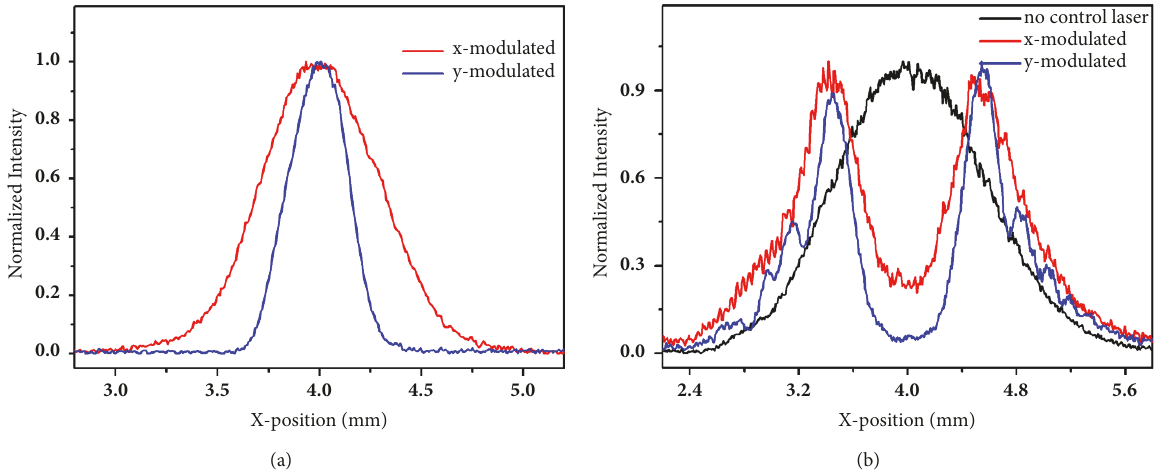
Figure 6: The corresponding cross line (y=0) of (a) control light and (b) signal light in Figure